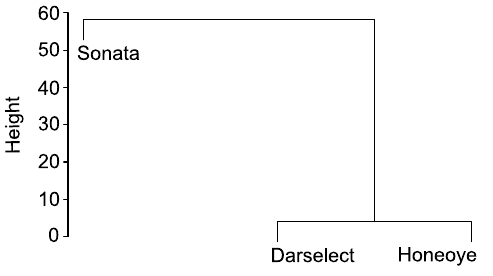
Figure 1. Difference between varieties due to the emission of floral volatile compounds. Differences between varieties are shown as euclidian distance. doi:10.1371/journal.pone.0072724.g001 PLOS ONE |